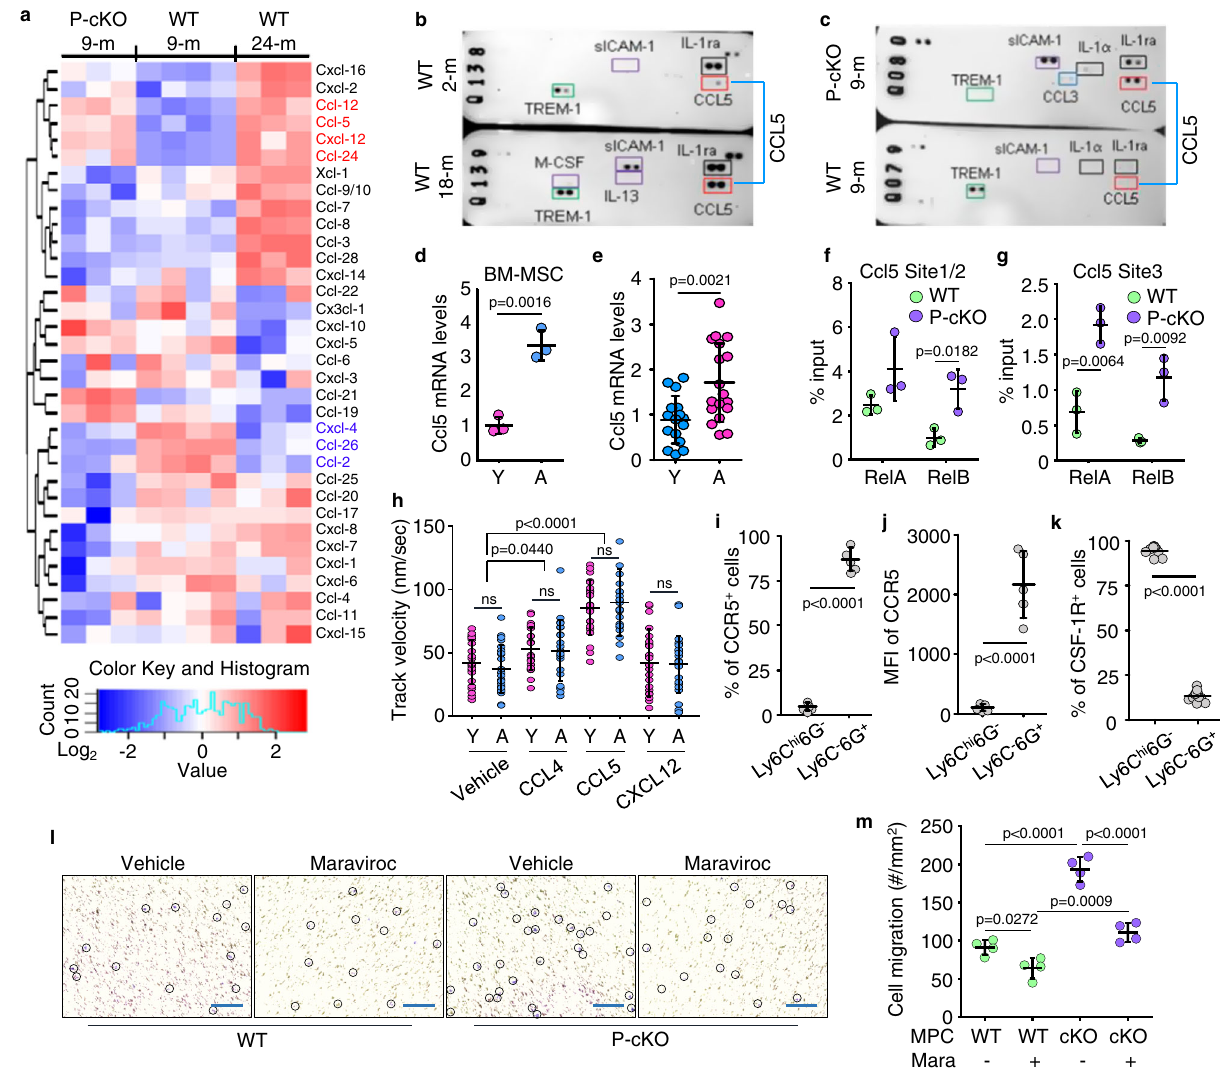
Fig. 5 | Aged and P-cKO mice have MPCs with increased CCL5 expression and increasednumbers ofTCNs in BM. a Heatmap of mouse chemokine levelstested usingreal-timeqPCRinbulkRNAextractedfromCD45 - cellsisolatedfromBMof9- mon-old TRAF3 fl / fl (WT)and Prx1 Cre TRAF3 fl / fl (P-cKO) mice and 24-mon-old TRAF3 fl / fl (WT) mice. n =4, 3, and 3 biologically independent male mice, respectively. b , c Cytokine array of BMprotein lysate from 2-and 18-mon-oldmale C57mice( b ) andfrom9-mon-oldWTandP-cKOmalemice( c ). d Relativelevelsof Ccl5 mRNAin bulk RNA from 3 rd passage BM-MSCs from 3- (young; Y) and 22-mon-old (aged; A) male C57 mice. Mean±SD ( n =3 biologically independent samples/group). e Relative levels of Ccl5 in bulk RNA from human vertebral specimens. Mean±SD ( n =16 young (Y) and 18 elderly (A) human subjects). f , g Sheared chromatin from WT and P-cKO BdMPCs used to perform DNA IP with RelA and RelB Abs or IgG control. RT-PCR usingdesigned primerswith putative κ Bbinding sites in Ccl5 gene promotors, normalized to input. Mean±SD ( n =3 biologically independent sam- ples/group). h TNs sorted from BM of 3- (young) and 22-mon-old (aged) male C57 mice attracted by chemokines, including CCL4, CCL5 and CXCL12. Velocity of TN